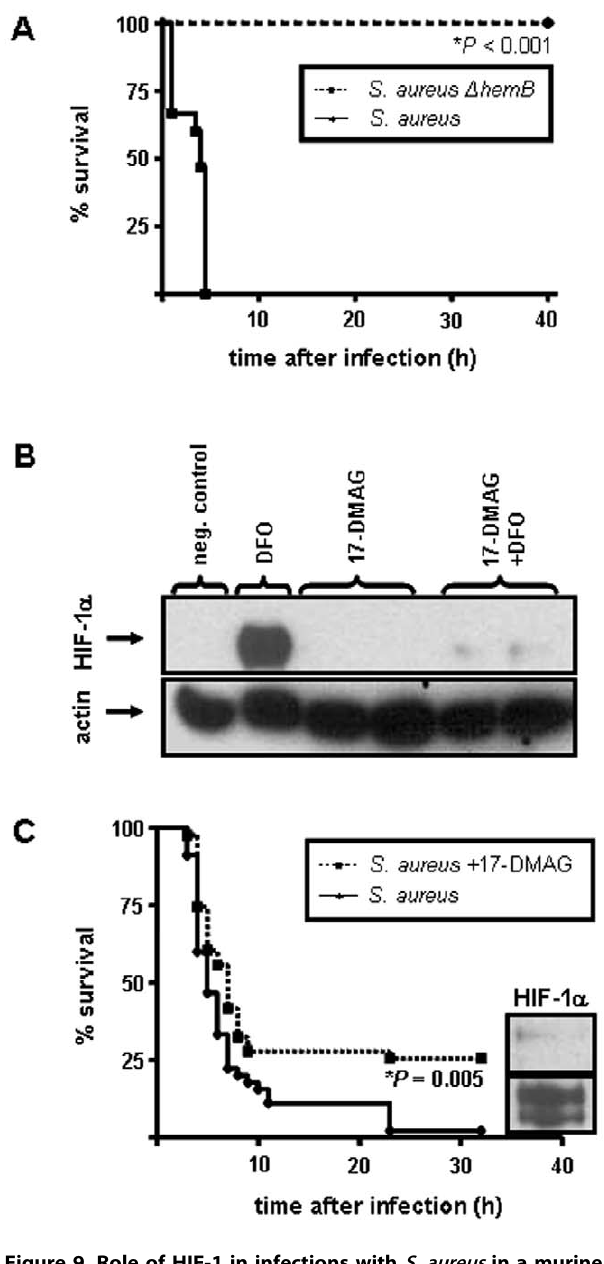
Figure 9. Role of HIF-1 in infections with S.aureus in a murine peritonitis model. (A) Survival of NMRI mice after intraperitoneal infection with S. aureus (wt; S. aureus 8325-4; n=8) or S. aureus D hemB (SCV, S. aureus erm V hemB 8325-4; n=8). Note the higher susceptibility of mice infected with S. aureus 8325-4 compared to the mice infected with S. aureus D hemB . *significant difference: P , 0.001. (B) Inhibition of DFO induced HIF-1 activation in HeLa-229 cells by 17-DMAG. Cells were incubated with 17 DMAG (10 m mol/L) for 16 hours following induction of HIF 1 activation by the iron chelator DFO (200 m mol/L) for six hours. HIF 1 a protein was analyzed in Western blots (loading control: actin). Negative control: uninfected cells. (C) Survival rate of NMRI mice after intraperitoneal infection with S. aureus ( S. aureus 8325-4). One group of mice was treated 24 h and 16 h before infection with the HIF-1 inhibiting compound 17-DMAG (25 mg/g body weight). Note the higher survival rate of 17-DMAG-treated mice (n=45) compared with control mice (n=45). *significant difference: P=0.005 (Kaplan-Meier analysis).